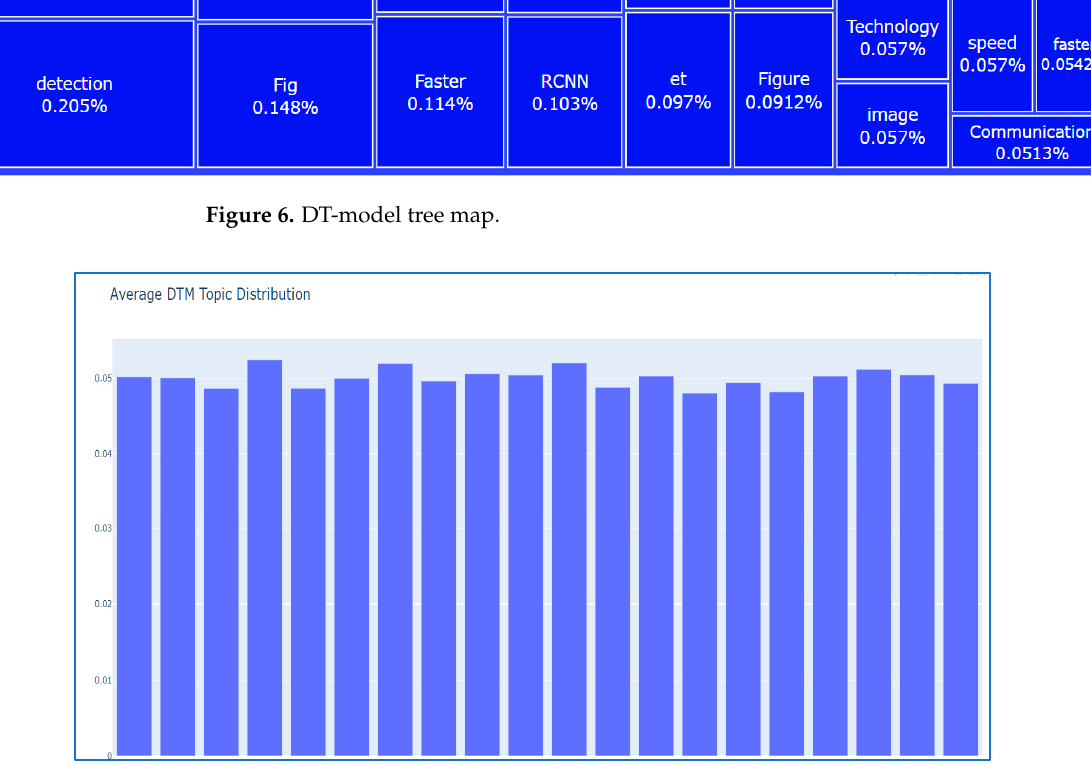
Figure 7. DTM topic average distribution map.